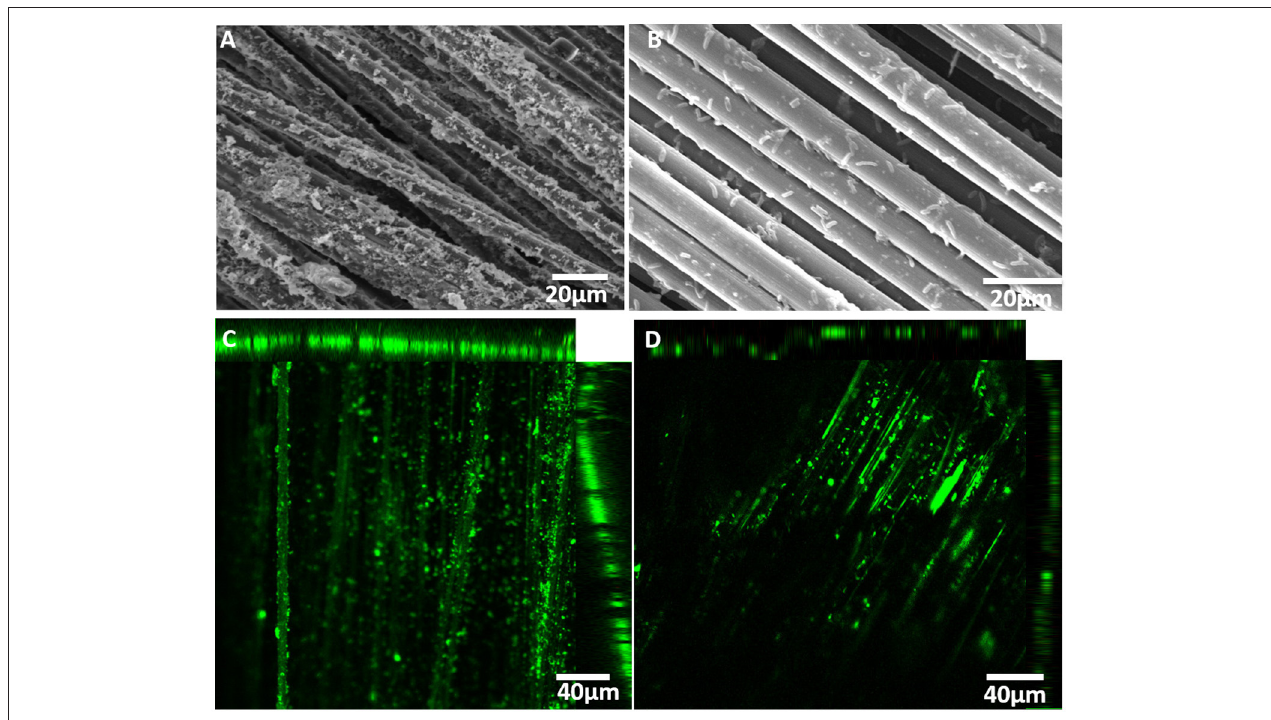
FIGURE 4 | SEM and CLSM images of (A, C) a PEDOT:PSS-carbon cloth and (B, D) of a carbon cloth cathode in S. ovata -driven MES reactors.